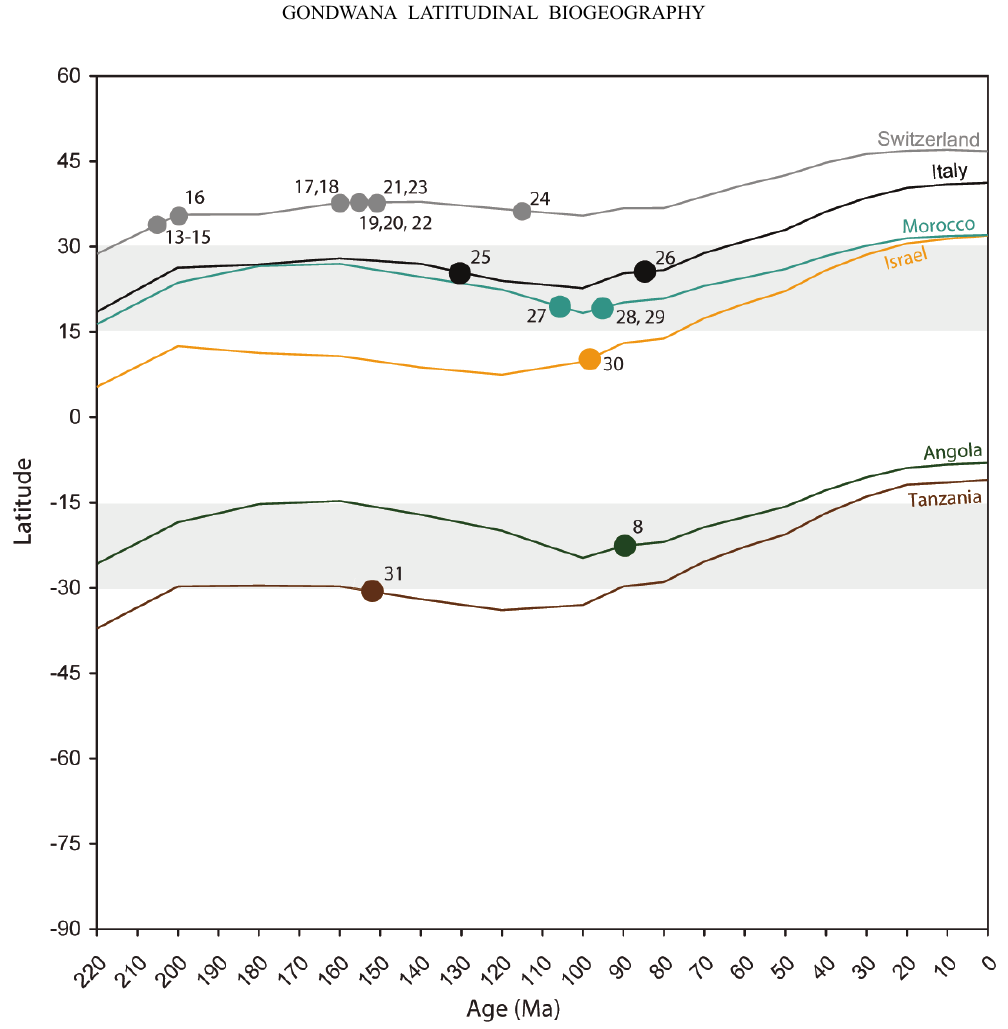
Fig. 4 – Latitudinal trajectories of Gondwana dinosaur localities and Laurasian localities in Switzerland (13-24) around the Mediterranean Sea region (localities listed by number in Table